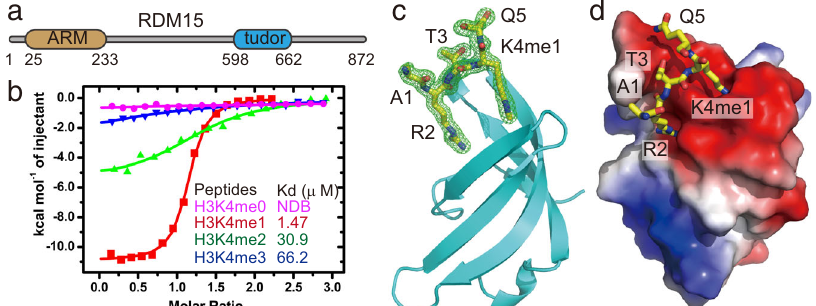
Fig. 5 The RDM15 Tudor domain speci fi cally recognizes H3K4me1 and the structure of its complex with the H3K4me1 peptide. a Schematic representation of the domain architecture of RDM15. b ITC binding curves between the RDM15 Tudor domain and peptides with different methylation states on the H3K4 site; the curves indicate that RDM15 prefers the H3K4me1 mark over either lower (H3K4me0) or higher (H3K4me2 or H3K4me3) methylation states. NDB no detectable binding. c Overall structure of the RDM15 Tudor domain in complex with the H3K4me1 peptide, with RDM15 shown as cyan ribbon and the peptide shown as stick representation. The composite-omit electron density map at the 1 σ level of the bound peptide is shown in a green mesh. d The RDM15 Tudor-H3K4me1 complex with RDM15 shown in an electrostatic surface and the peptide as stick representation. The interaction is mainly mediated by H3R2 and H3K4me1 residues, which insert their side chains in two negatively charged surface grooves of the